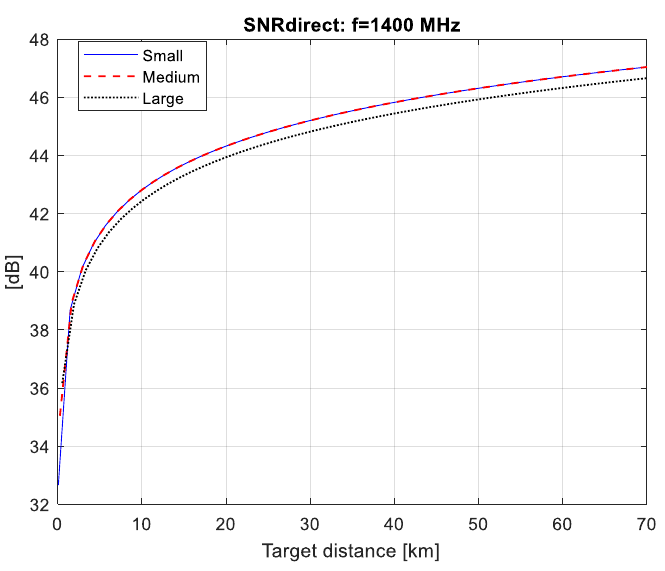
Figure 9. SNR direct values for lunar Figure 9. 𝑆𝑁𝑅 𝑑𝑖𝑟𝑒𝑐𝑡 values for lunar FSR. Figure 9. 𝑆𝑁𝑅 𝑑𝑖𝑟𝑒𝑐𝑡 values for lunar FSR.